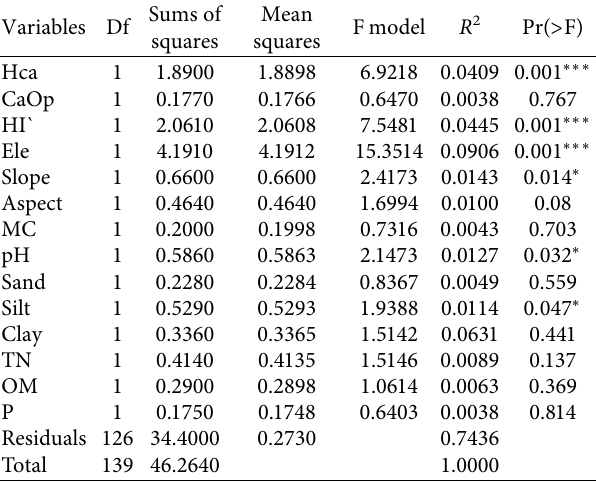
Figure 5: Canonical correspondence analysis (CCA) ordination diagram of 140 plots and 6 signifcant environmental variables and plot number distribution in four community types.